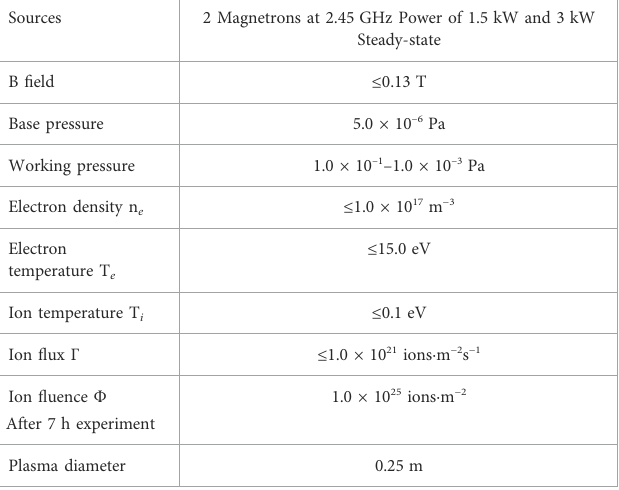
TABLE 1 Summary of the main features and plasma parameters of GyM linear device located at ISTP-Milan.